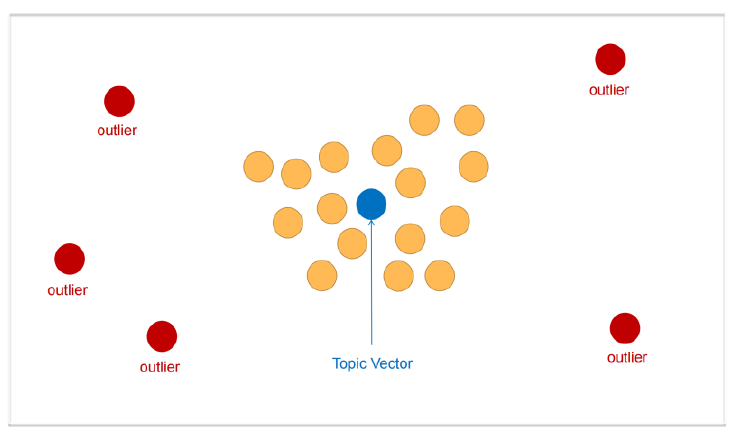
Figure 3. The topic vector was the centroid of the dense area of news titles identified by HDB-SCAN.